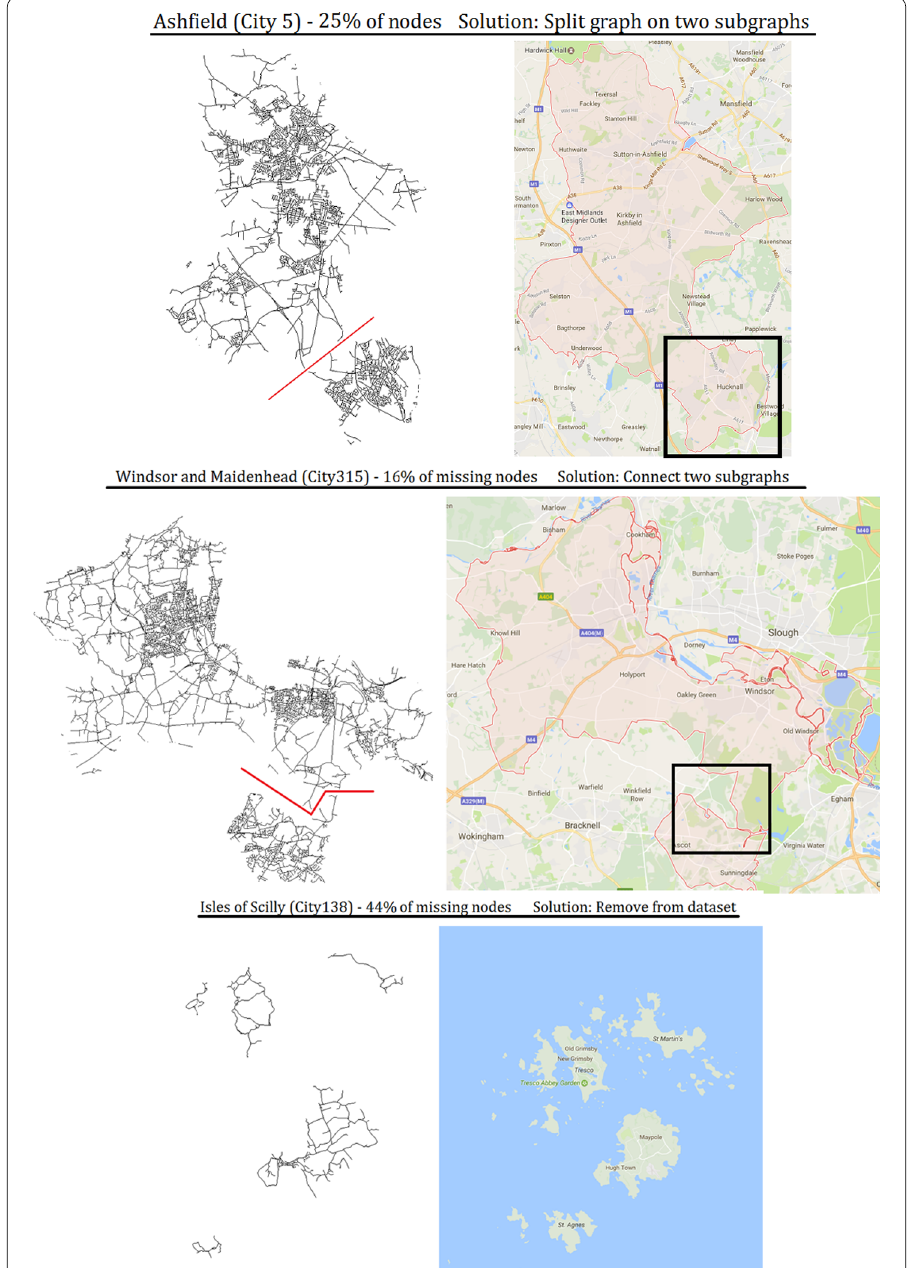
Figure 5 Three situations leading to a largely disconnected road network. Top: hamlet for which the access clearly lies outside the main area. Middle: a very small but critical road section is administratively in another LAD. Bottom: the whole area is formed of